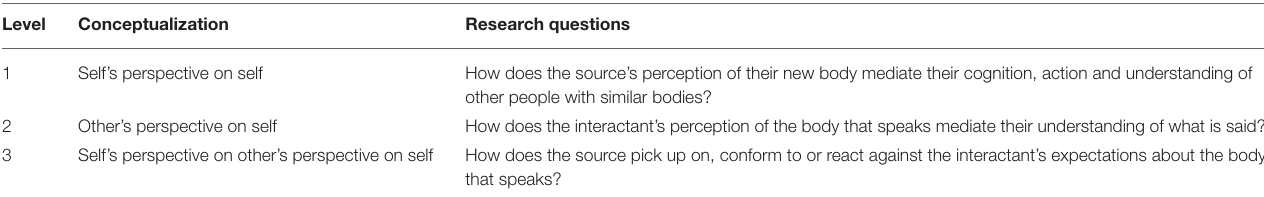
TABLE 2 | A conceptual framework for studying the body that